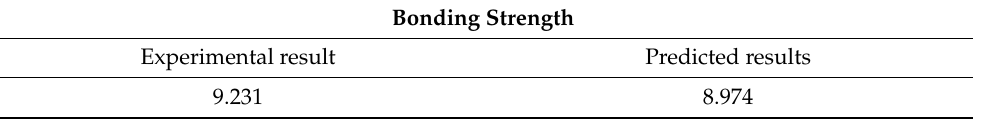
Table 6. Confirmation